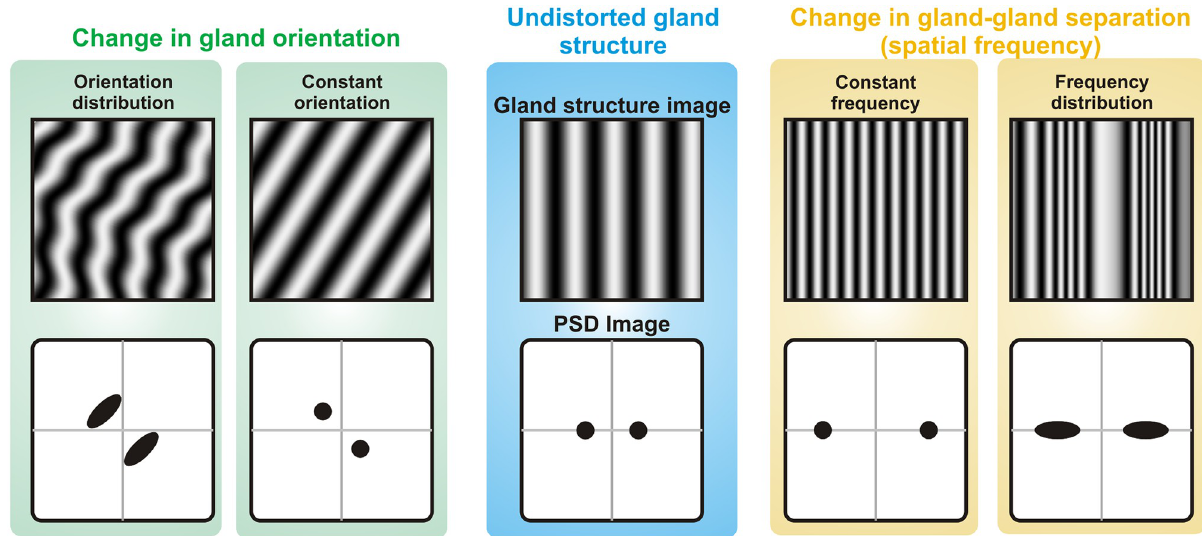
Fig 2. Schematic illustration of 2D Fourier Transformation. Transformation of an image of undistorted gland pattern results in a PSD image showing two sharp peaks of well-defined position and orientation (black circles in bottom images). Orientation and separation of these peaks correspond to direction and frequency of the gland pattern, respectively. When the gland pattern is not uniform, some distribution in frequency and orientation occur. As a result, the spectral features in PSD images tend to smear out.